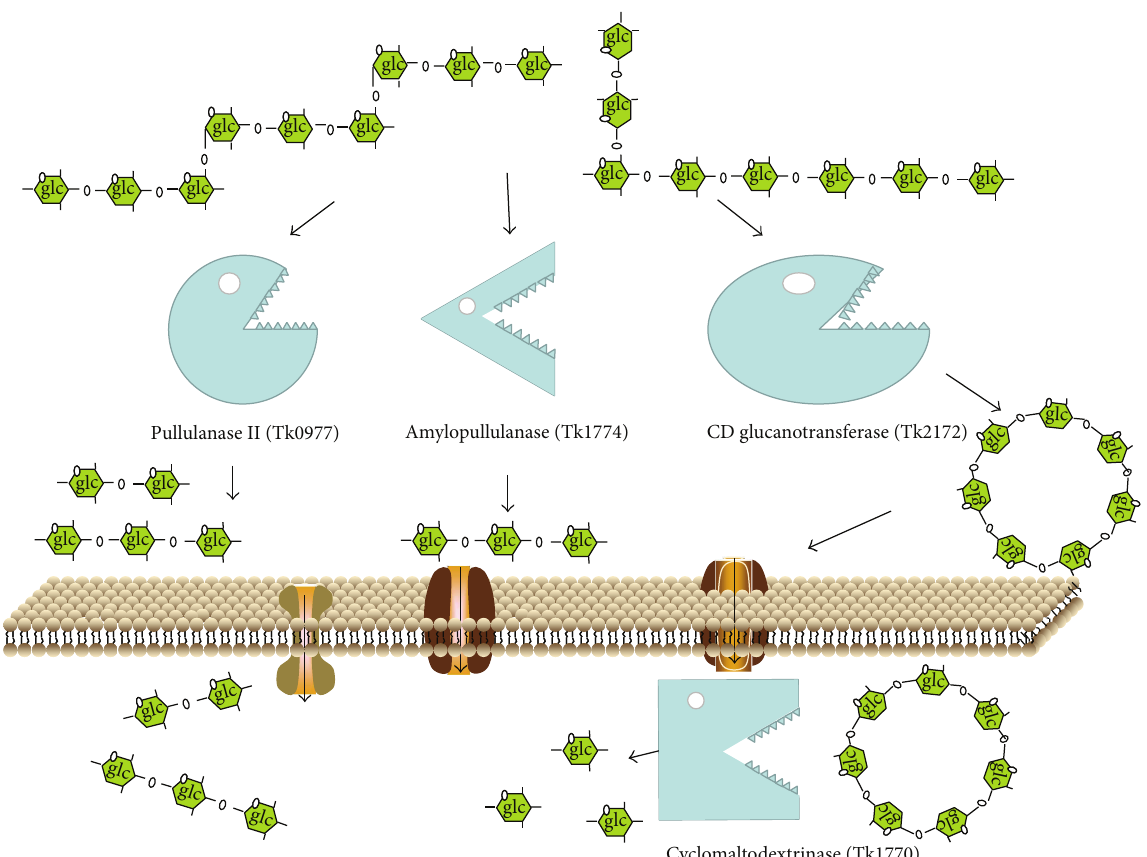
Figure 6: Proposed model for the degradation of starch in T. kodakarensis